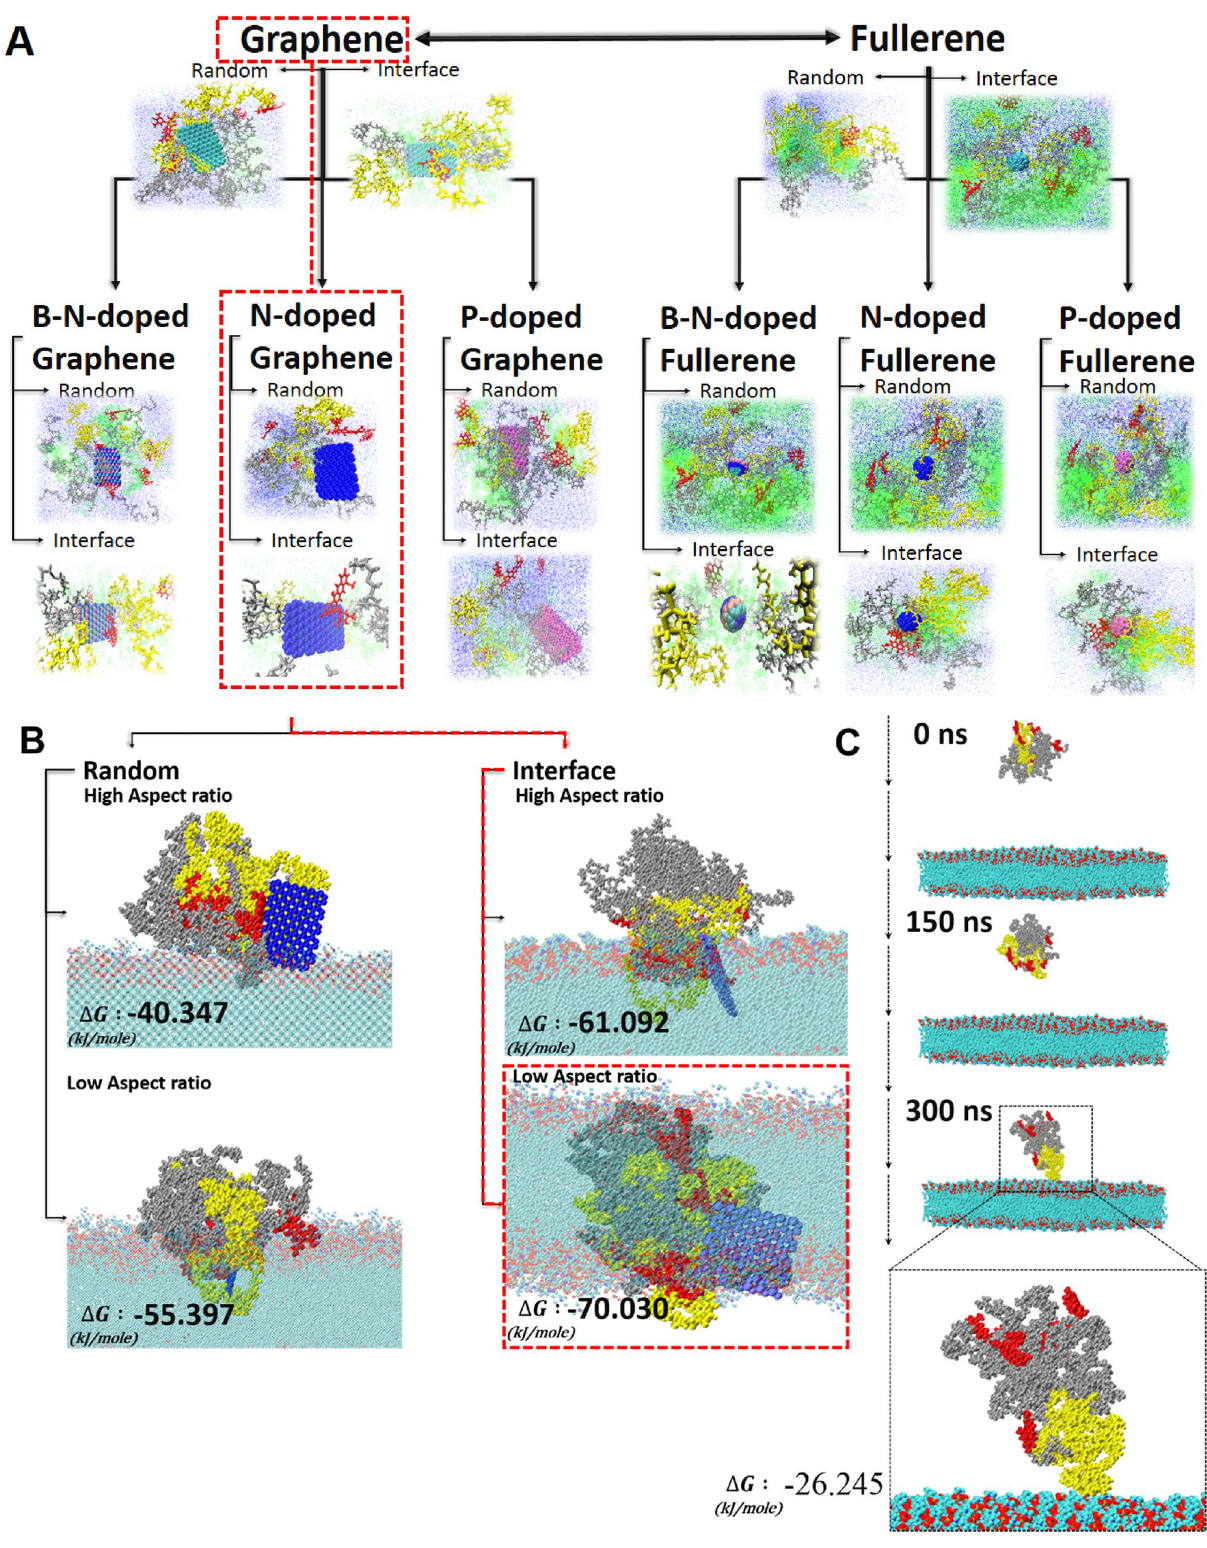
Figure 4. The roadmap for the selection of suitable nanocarbons for the self-assembly of PNPs. (A) Assessments done in the first part of the current paper can be presented in a tree diagram where the N-doped graphene provided the best qualities of NPs among its peers. ( B) Translocation of PNPs produced with N-doped graphene with varying aspect ratios in both methods of synthesis at the end of the 300 ns simulations. ( C) Stepwise translocation of PNPs prepared in the random method without any